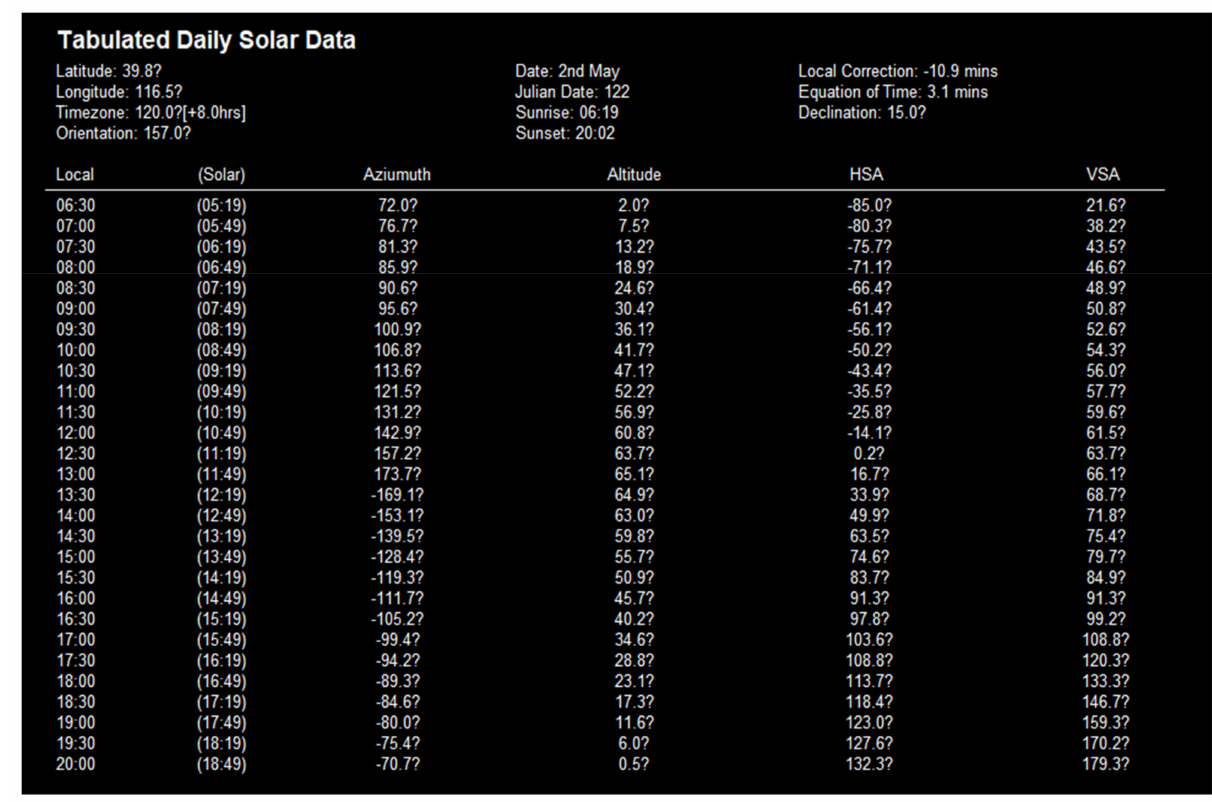
Figure 15. Annual solar radiation